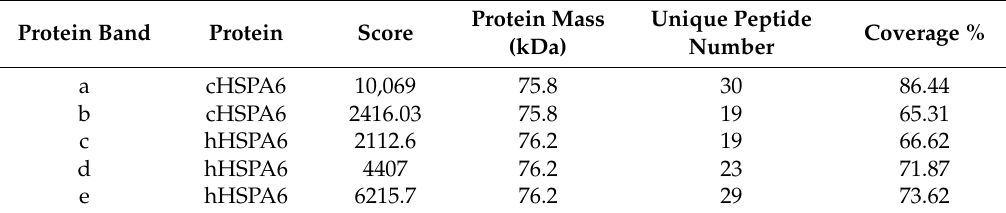
Table A1. Mass spectrometry results of the analyzed protein bands.